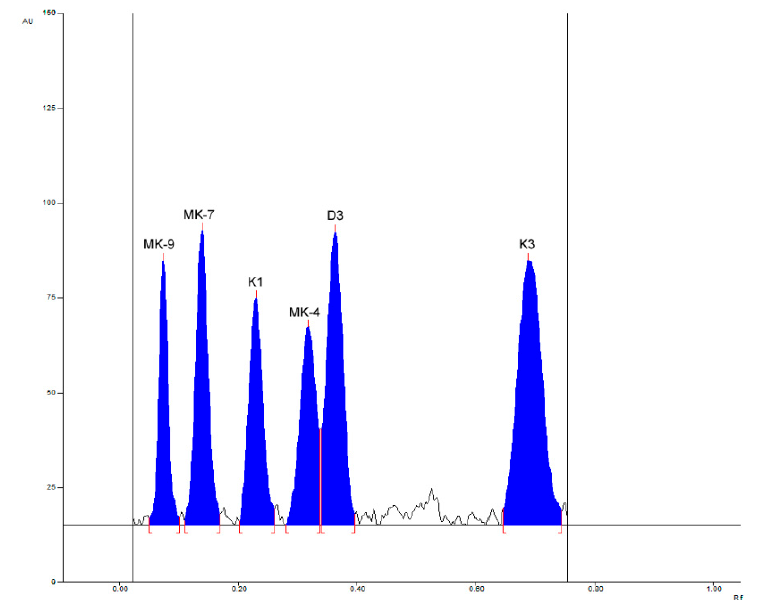
Figure 2. Example densitogram registered for a solution of a mixture of standards at 254 nm.